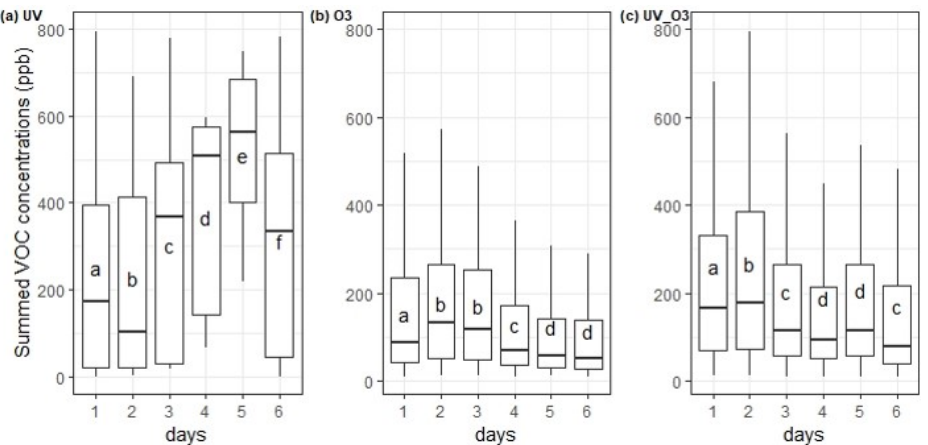
Figure 3. Summed VOC concentrations for each day (24h period) incubation condition (a) UV, (b) O 3 , and (c) UV_O 3 . Letters indicate the statistical difference obtained by the Tukey test.